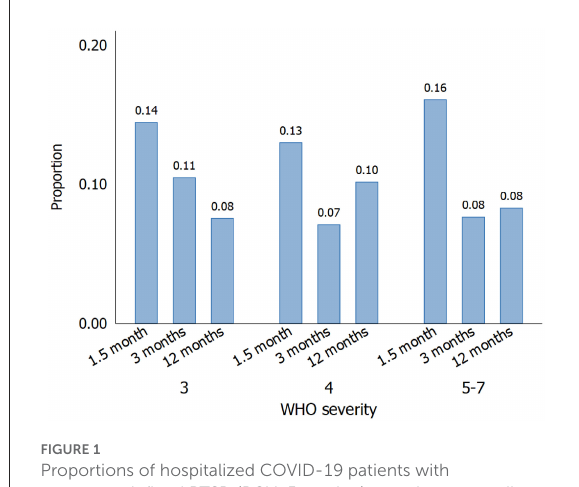
FIGURE1 Proportions of hospitalized COVID-19 patients with symptom-defined PTSD (DSM-5 scoring) over time, according to WHO disease severity: 3, no oxygen requirement ( n = 87); 4, oxygen by mask or nasal prongs ( n = 121); 5–7, high-flow oxygen, non-invasive ventilation or intubation/mechanical ventilation ( n = 43).